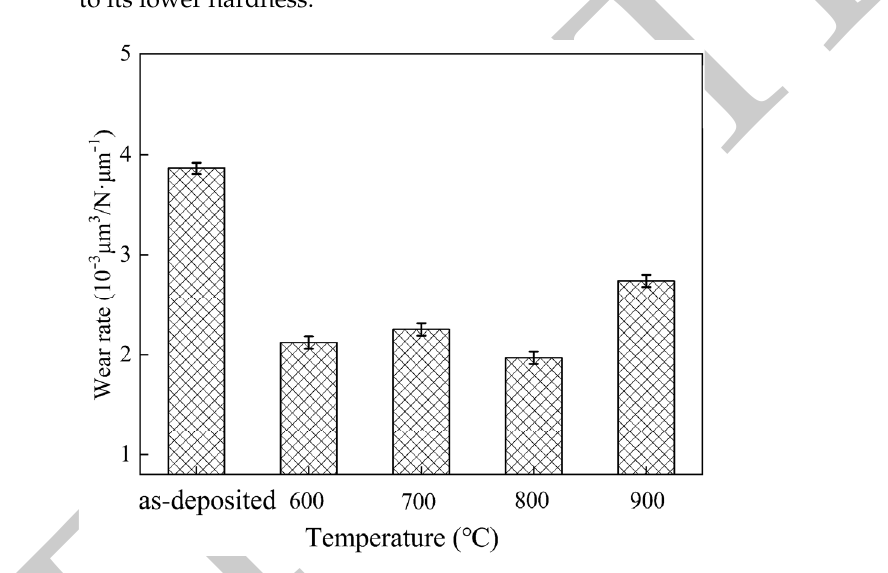
Figure 10. Wear rate of the AlCrTiSiN coatings before and after annealing at different temperatures.